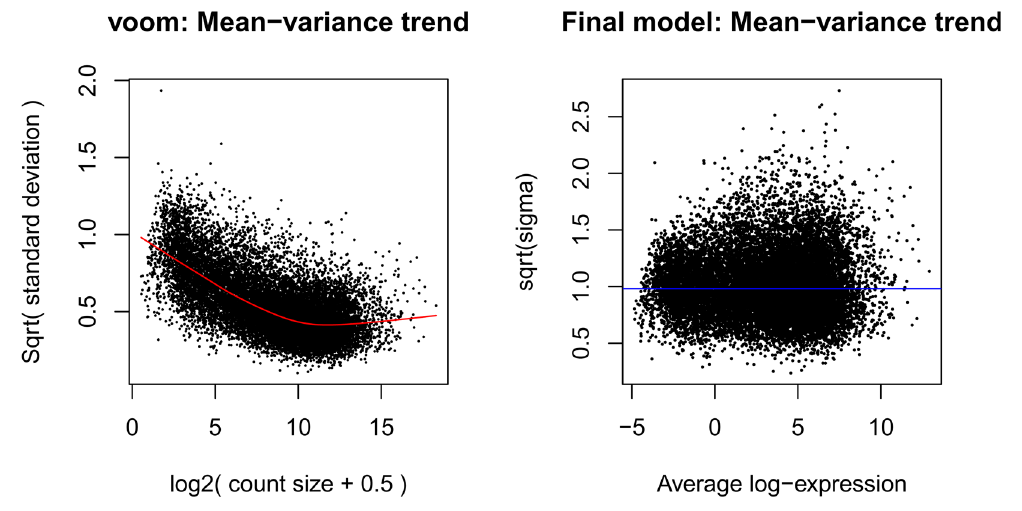
Figure 4. Means (x-axis) and variances (y-axis) of each gene are plotted to show the dependence between the two before voom is applied to the data ( A ) and how the trend is removed after voom precision weights are applied to the data ( B ). The plot on the left is created within the voom function which extracts residual variances from fitting linear models to log-CPM transformed data. Variances are then rescaled to quarter-root variances (or square-root of standard deviations) and plotted against the mean expression of each gene. The means are log -transformed mean-counts with 2 an offset of 2. The plot on the right is created using plotSA which plots log residual standard deviations against mean 2 log-CPM values. The average log residual standard deviation is marked by a horizontal blue line. In both plots, each 2 black dot represents a gene and a red curve is fitted to these